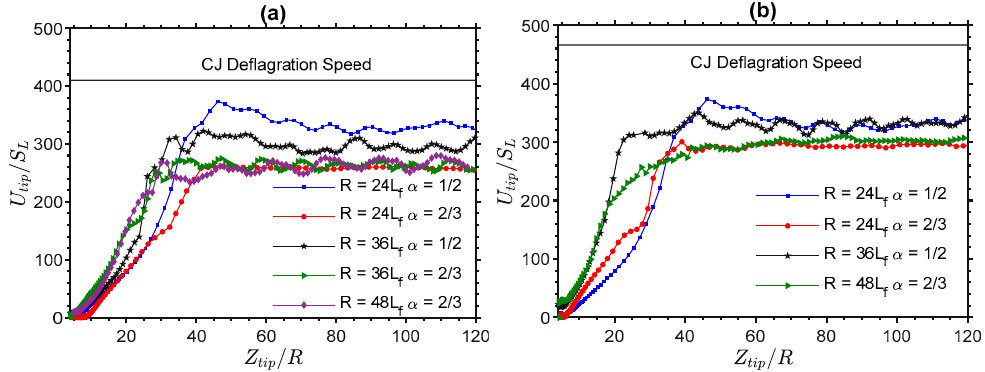
Figure 13. The scaled flame tip velocity U tip / S L versus the scaled flame position Z tip / R for the Θ = 8 ( a ) and Θ = 10 ( b ) flames propagating in channels of various widths and blockage ratios.